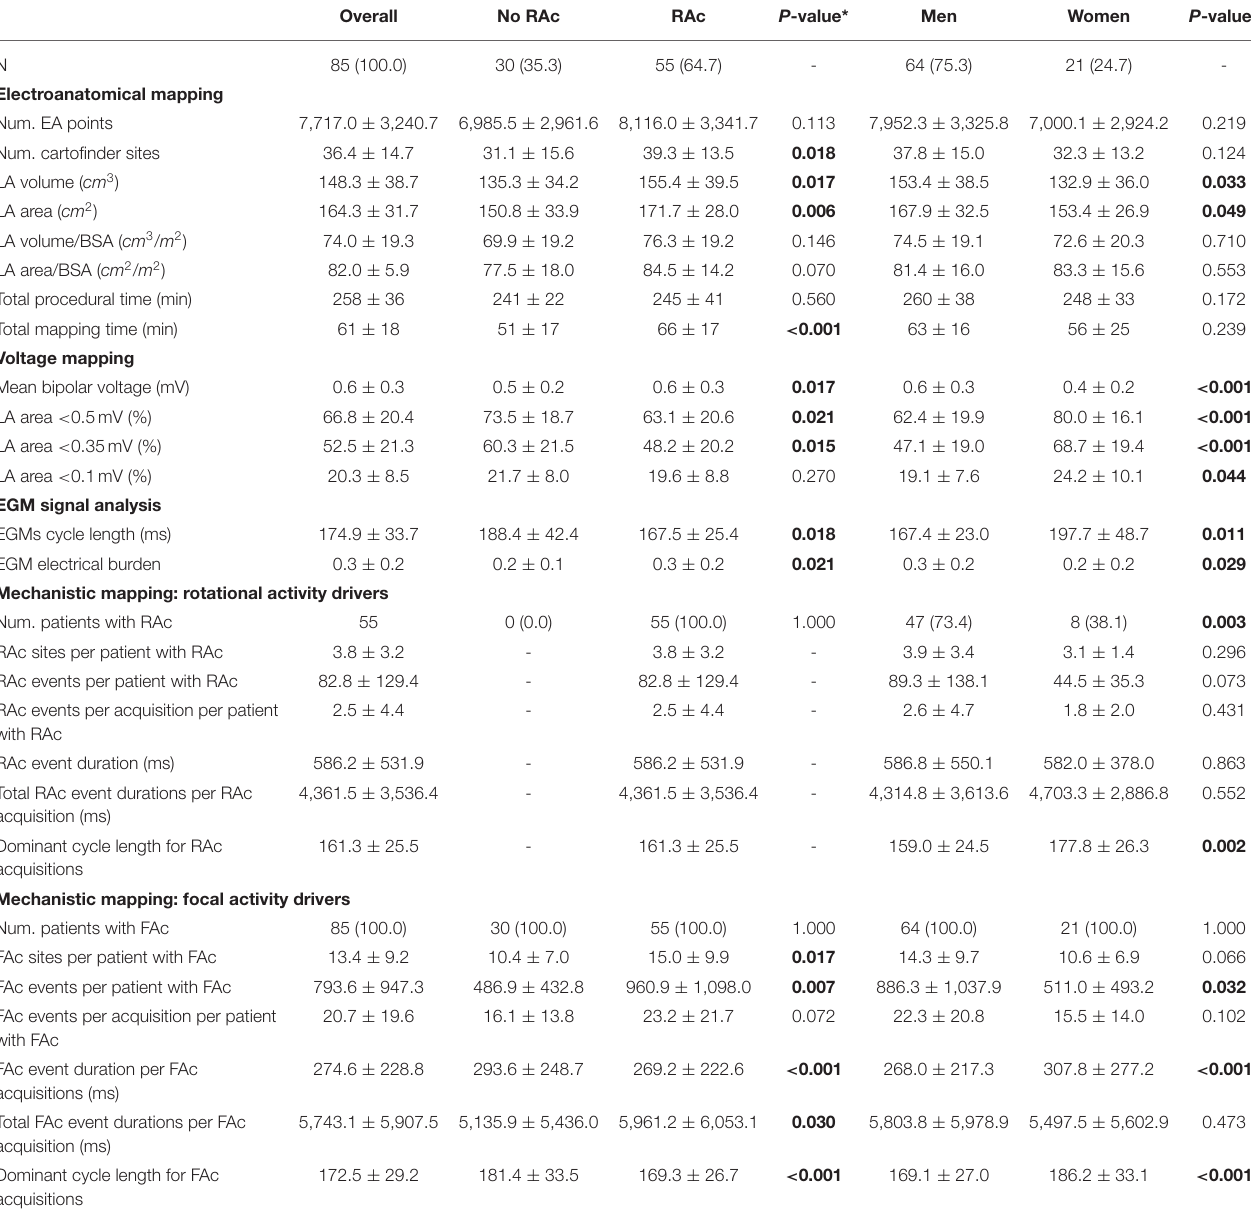
TABLE 2 | Electroanatomical (EA) and AF drivers mapping. RAc and gender differences. Overall No RAc RAc P -value* Men Women P